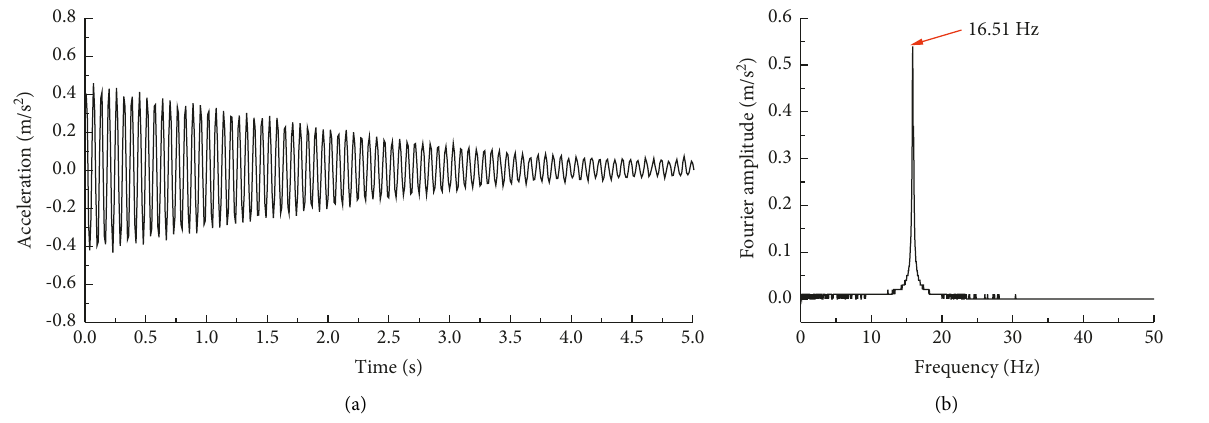
Figure 6: Frequency identification of model I. (a) Acceleration time history. (b) Fourier spectrum.